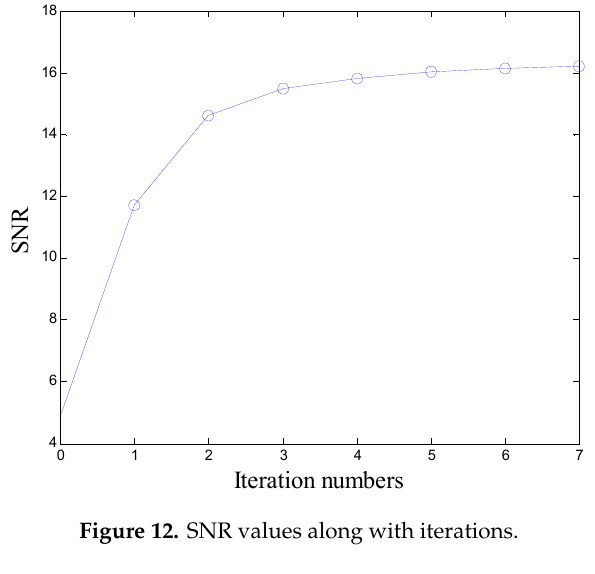
Figure 12. SNR values along with iterations.